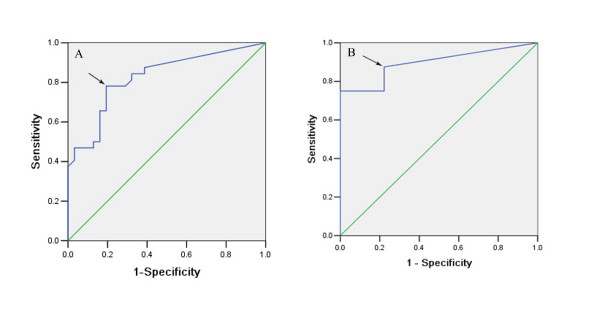
ROC curve of MLR for predicting survival rate. A. For predicting the 3-year survival rate; B. For predicting the 5-year survival rate.